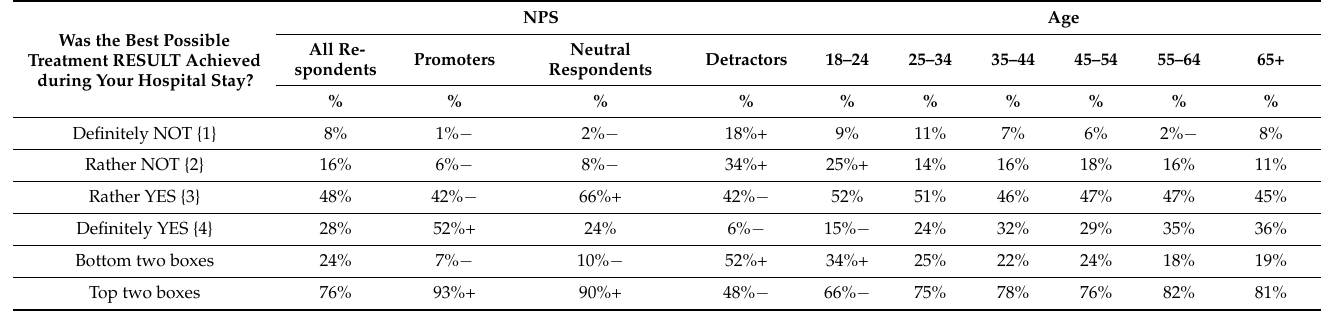
Table 7. Analysis of patients’ opinion on the achievement of the best possible treatment result during